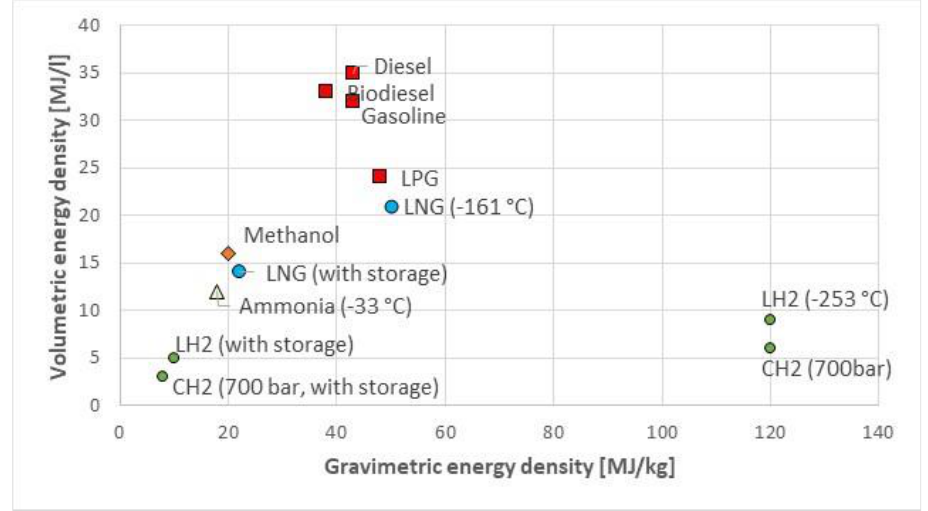
Figure 3. Gravimetric and volumetric energy density of different